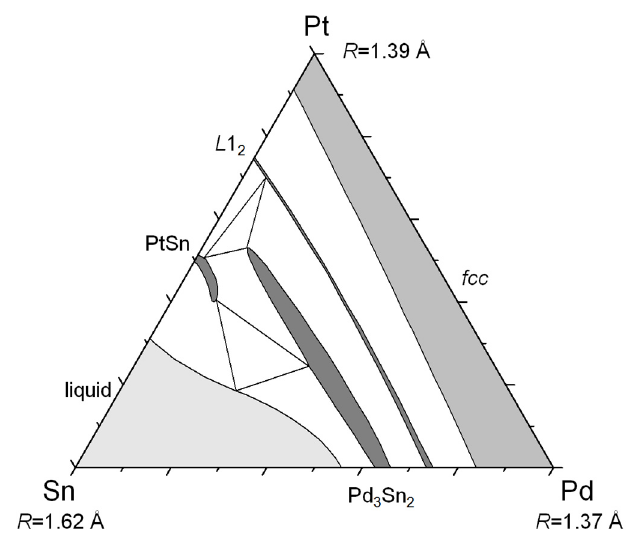
Figure 1. Isothermal section at 1000 °C of the Sn–Pt–Pd system (redrawn from [1], Copyright 1981, Mineralogical Association of